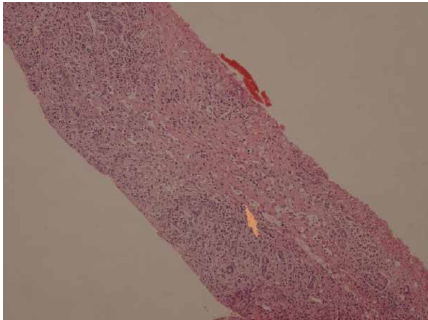
Figure 2: Liver biopsy showing portal expansion and bridging fibrosis. HE 10 × 10.